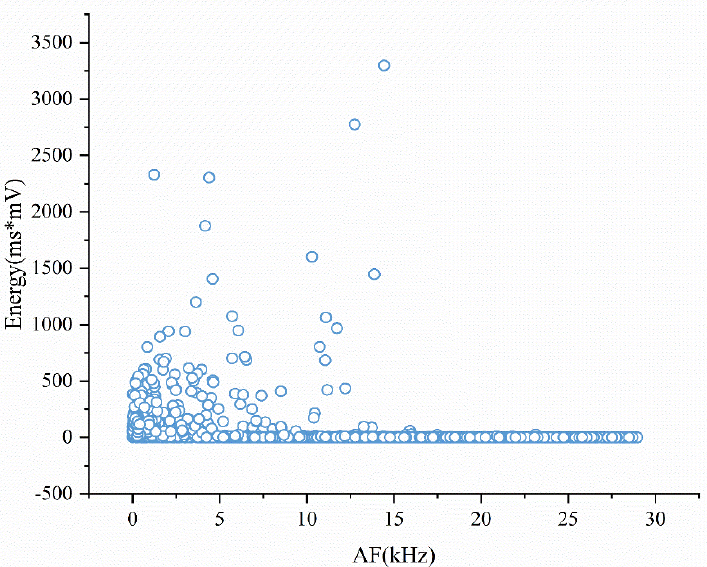
Figure 23. Average frequency-energy correlation diagram of noise signal of Yellow River Bridge.